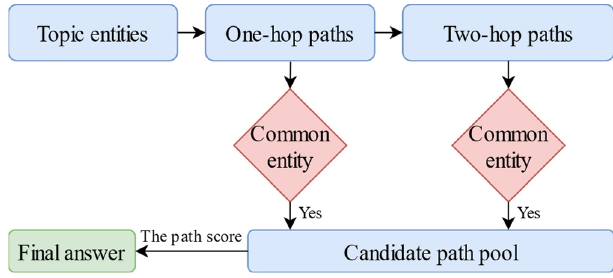
Figure 4. The workflow of subsystem